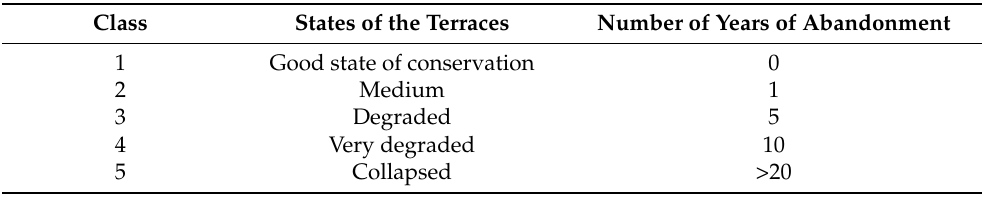
Table 1. The 5 age groups of abandonment of terraces in the territories of Tizerkine and Timzemzit, Western Anti-Atlas,